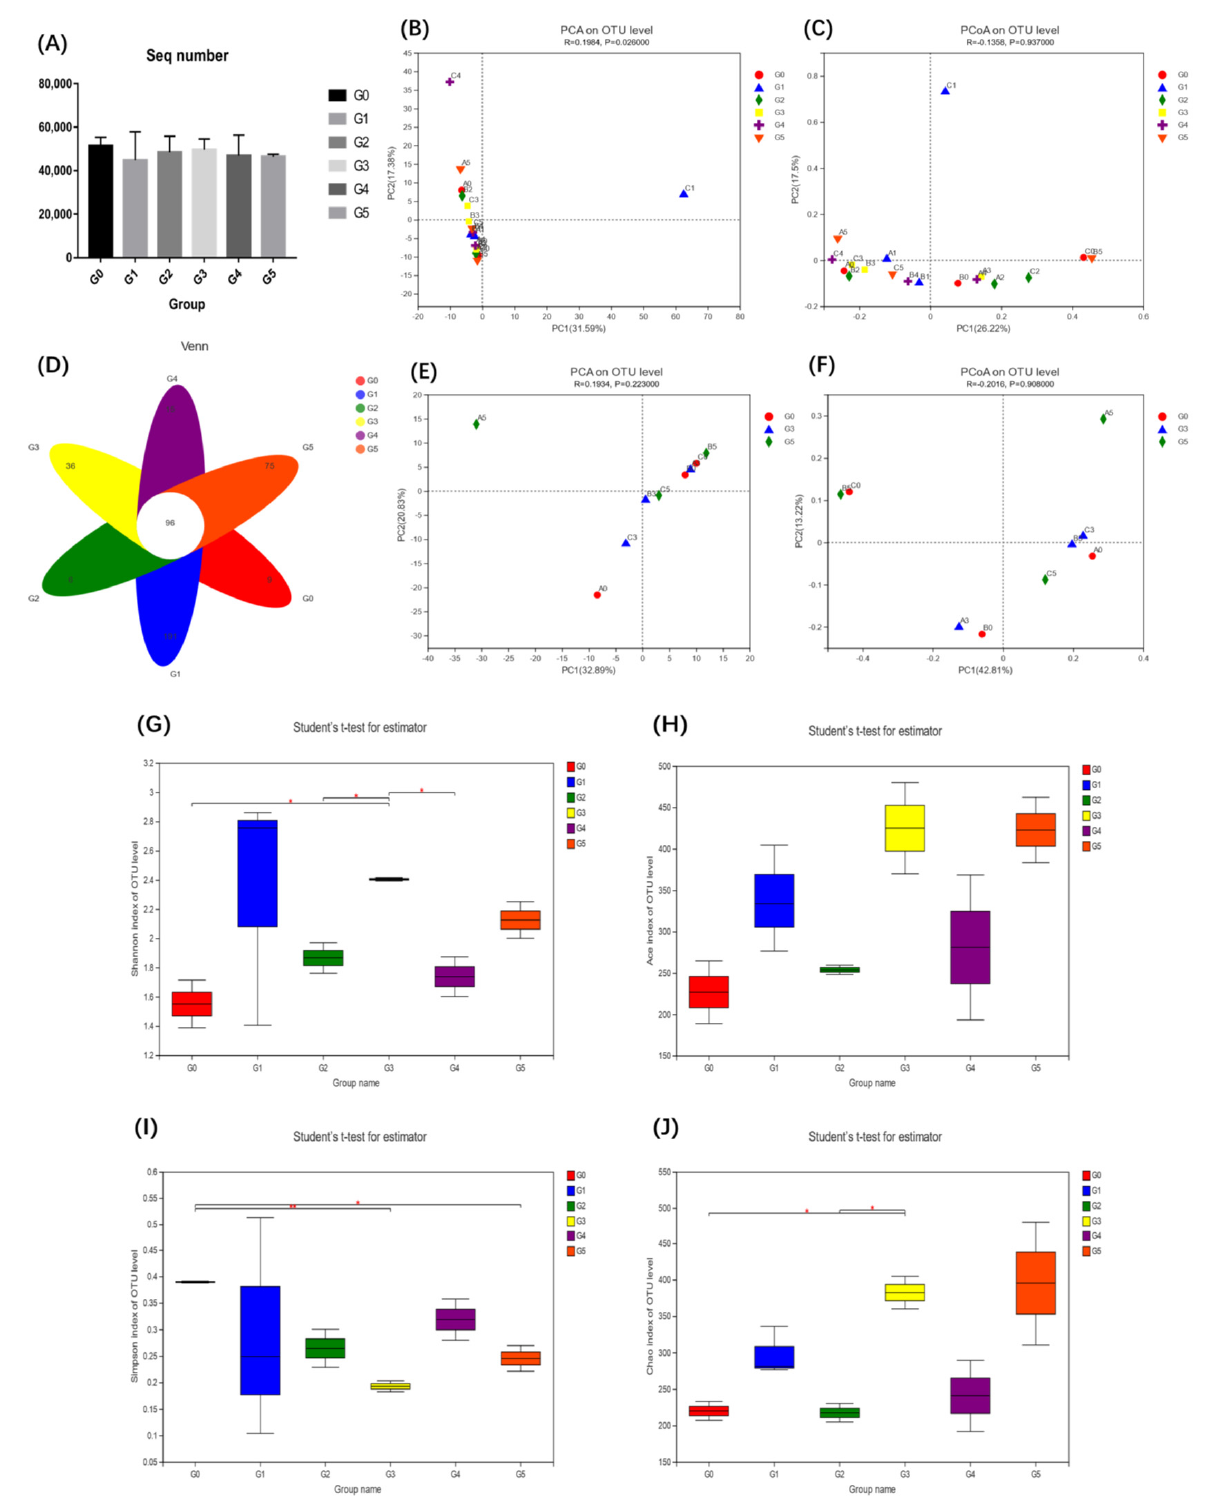
Figure 2. Comparison of the intestinal community composition, diversity, and richness between all groups. ( A ): the sequence count; ( B , C ): the PCA and PCoA analysis at the OTU level; ( D ): the OTU overlap analysis; ( E , F ): the PCA and PCoA analysis of G0, G3, and G5 groups; ( G ): Shannon index; ( H ): Ace index; ( I ): Simpson index; and ( J ): Chao1 index. n = 3 per group. * p <0.05, ** p <0.01.